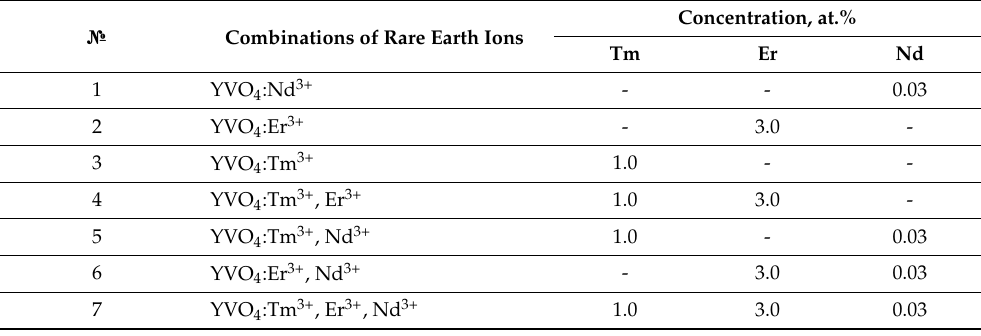
Table 1. Compositions of the crystalline particles.